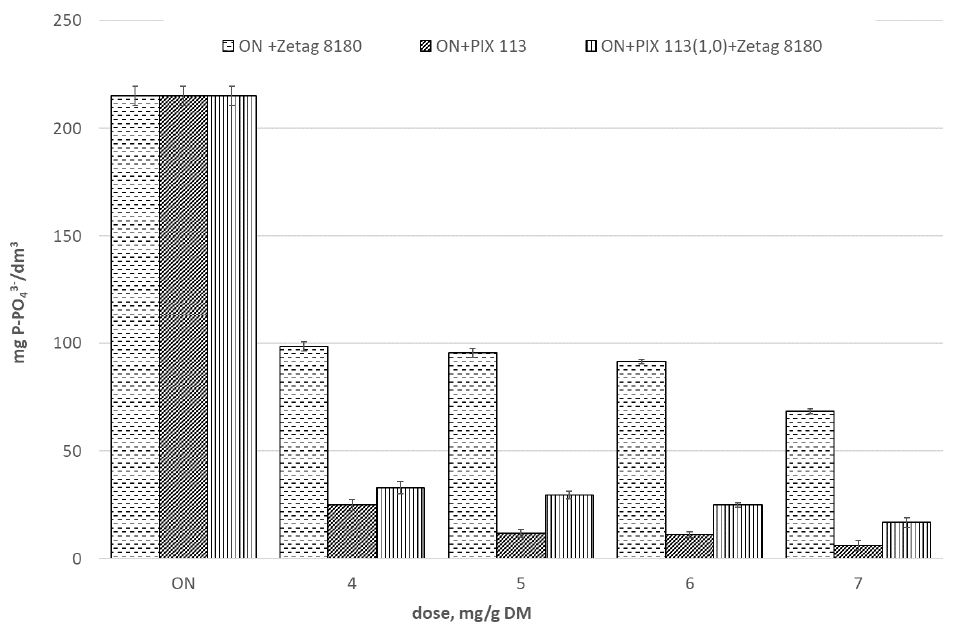
Figure 9. Phosphate changes in filtrate after sludge dewatering. Sludge sonicated (A 1 = 15.25 µm) and prepared with selected chemical reagents.